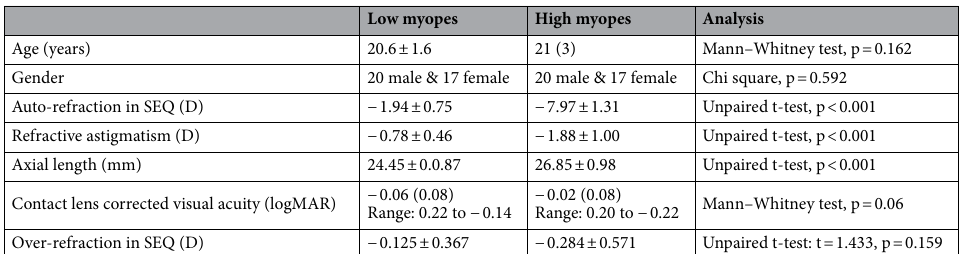
2 2 + 175 − y (cid:30) (cid:29)